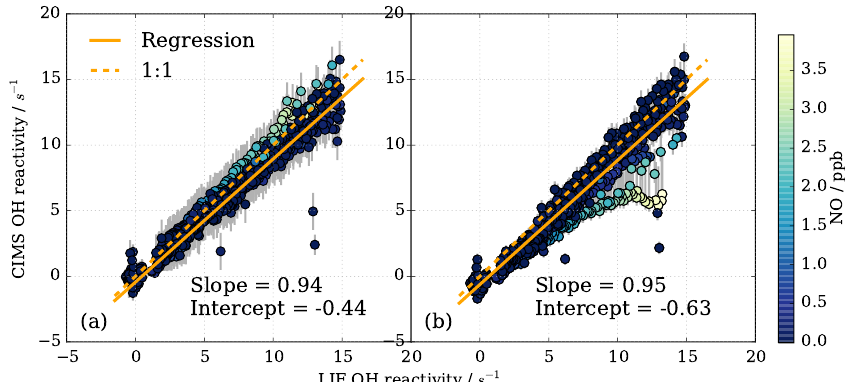
Figure 13. Subset of OH reactivity measurements from instrument comparison (Fuchs et al., 2017) for OH reactivity up to 15s − 1 and NO concentrations up to 4ppb (716 data points). (a) CIMS data treatment includes eight parameter NO correction, (b) CIMS data are not corrected for NO presence, but a positive NO-dependent uncertainty is associated with the measurement (Fig.